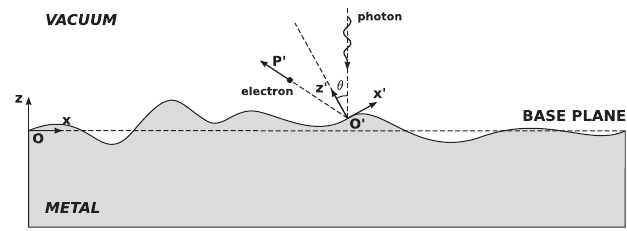
FIG. 7. The schematic plot for the bulk photoemission on a 2D random surface. The definitions of coordinates and variables are marked in the